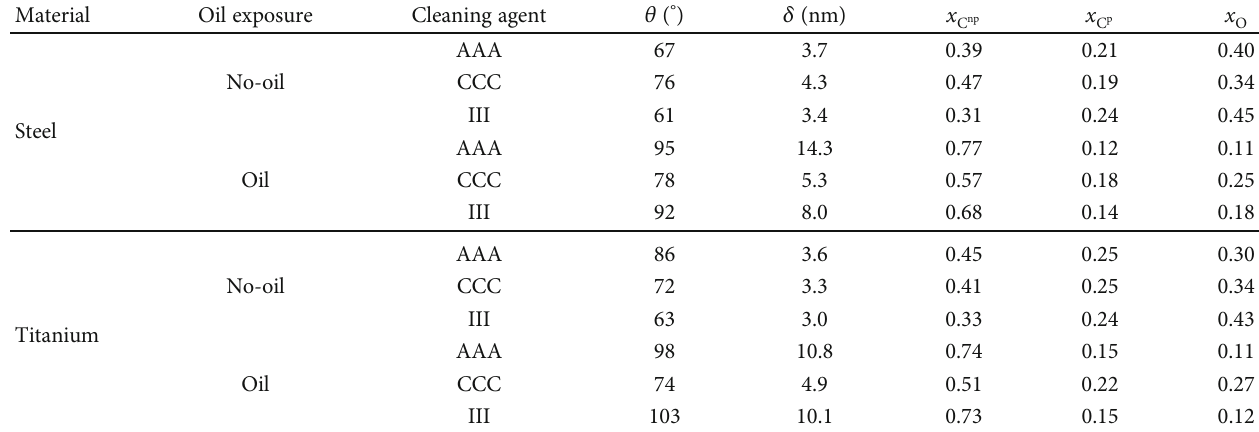
Table 2: Results of Becker et al. [20] for the water contact angle θ , adsorbate layer thickness δ , and atom number fractions of oxygen x carbon x C p , and nonpolar carbon x C np in the adsorbate layer measured for the di ff erently prepared technical steel and titanium samples. The statistical uncertainty of the water contact angle is ±5 ° . No information on the statistical uncertainty of the atom number fractions is available, but it can be assumed that they are similar to those reported in Table 1 as the same methods were